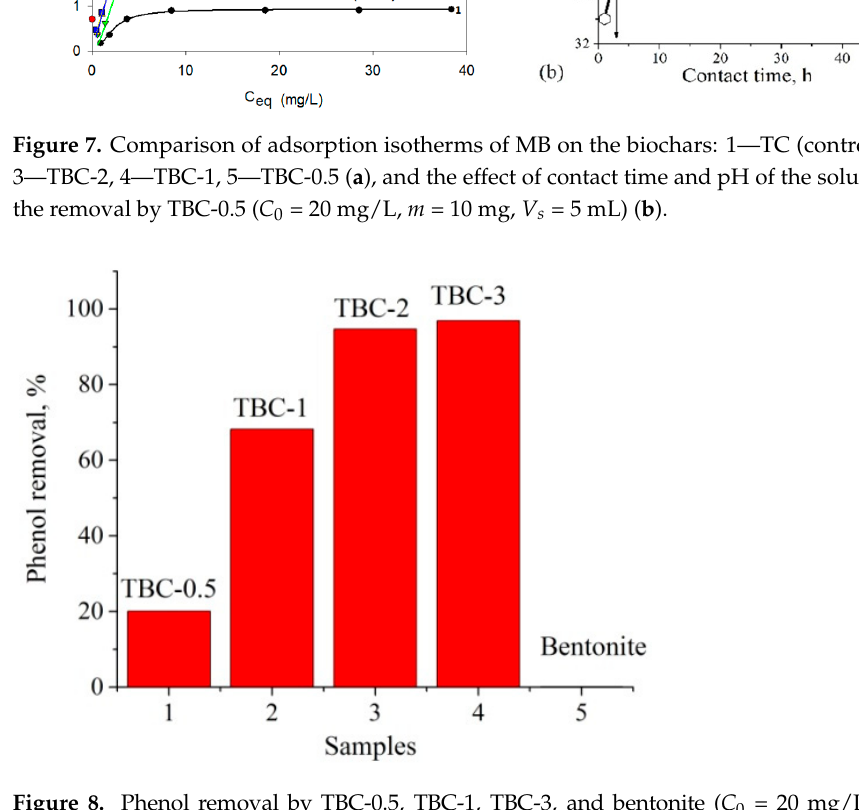
Figure 8. Phenol removal by TBC-0.5, TBC-1, TBC-3, and bentonite ( C 0 = 20 mg/L, m = 10 mg, V s = 5 mL).